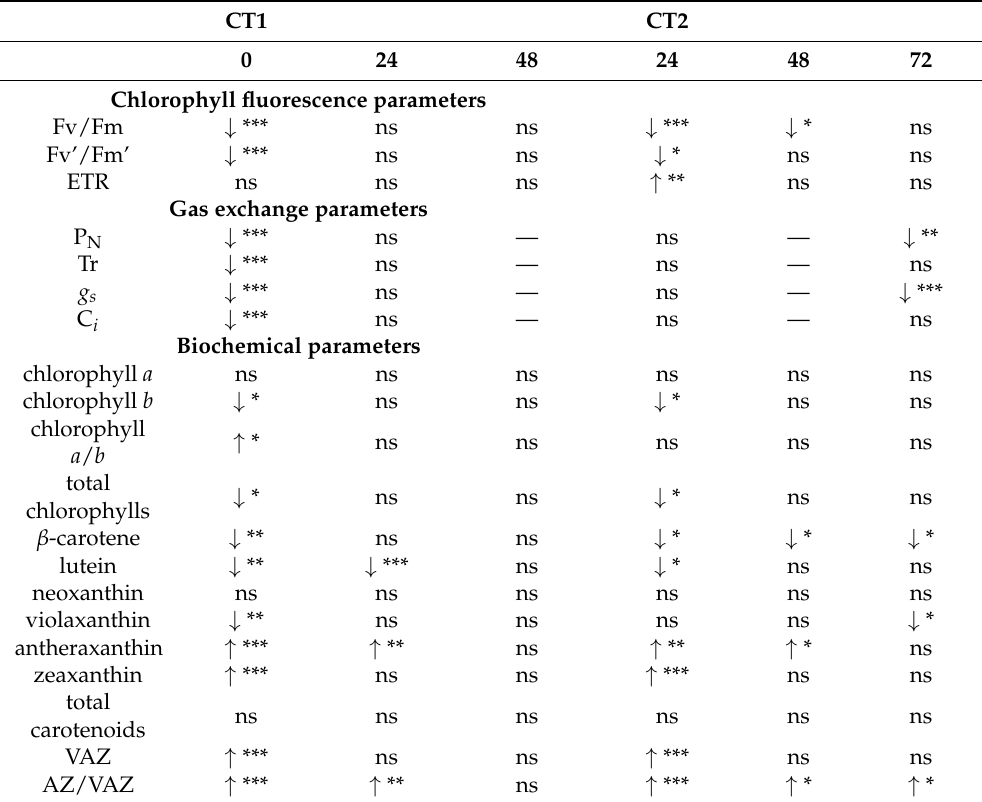
Table 1. The results of contrast analysis of physio-biochemical parameters in leaves of sweet cherry trees exposed to one (CT1) or two (CT2) cold nights. Measurements and samplings were performed at time 0, 24, and 48 for CT1 trees and at time 24, 48, and 72 for CT2 trees and compared with the corresponding controls. CT1 CT2 0 24 48 24 48 72 Chlorophyll fluorescence parameters Fv/Fm ↓ *** ns ns ↓ *** ↓ * ns Fv’/Fm’ ↓ *** ns